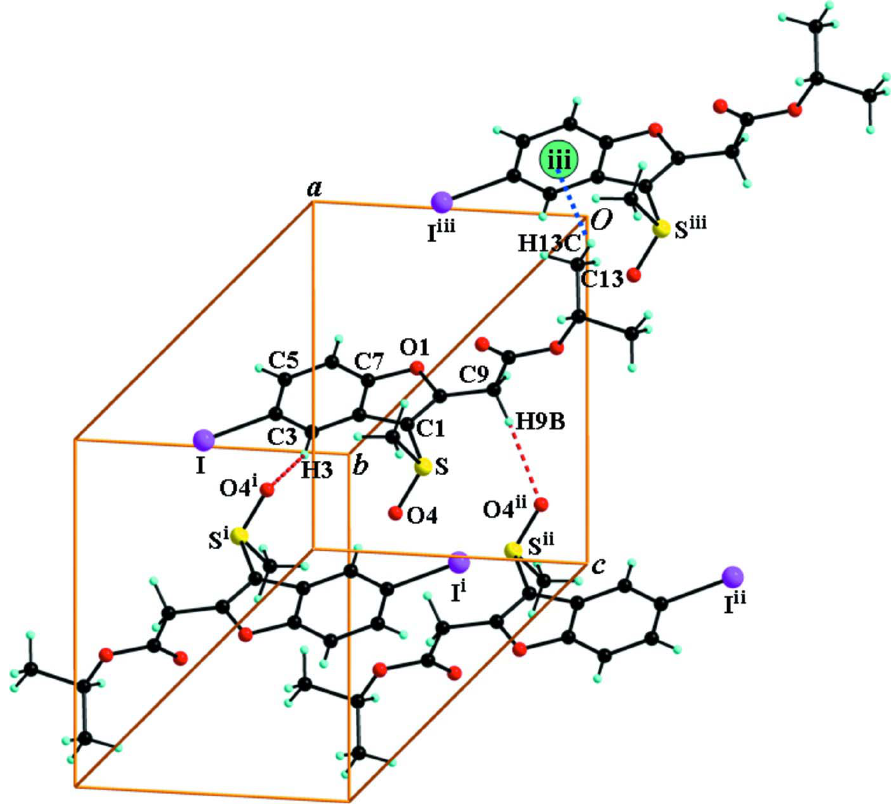
Figure 2 C—H··· π and C—H···O interactions (dotted lines) in the title ompound. Cg denotes ring centroid. [Symmetry code: (i) - x +1, - y +1, - z +1; (ii) - x , - y +1, - z +1; (iii) x , y -1, z